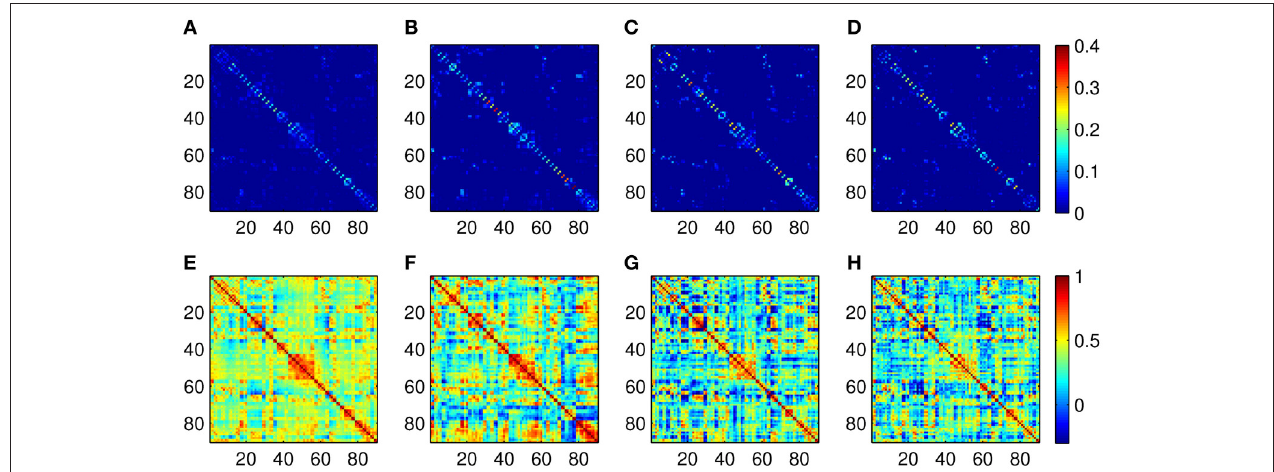
FIGURE 4 | Examples of association matrices computed by using ASR and the Pearson correlation. (A) Mean matrix averaged over 20 subjects by using ASR. Panels (B–D) are association matrices derived from ASR on three randomly selected subjects. (E) Mean matrix averaged over 20 subjects by using the Pearson correlation. Panels (F–H) are corresponding association matrices derived from the Pearson correlation on the above three subjects